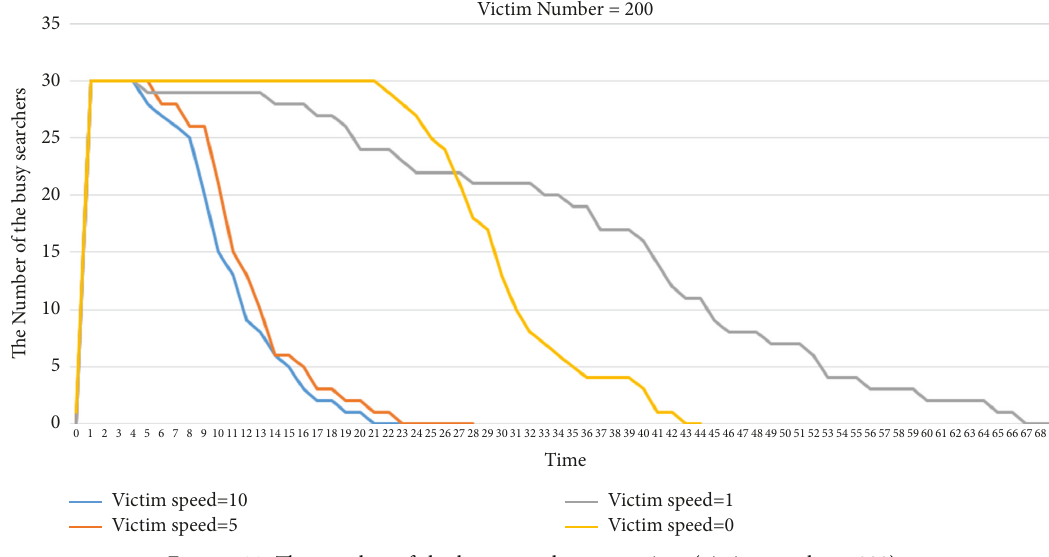
Figure 11: The number of the busy searchers over time (victim number � 200).